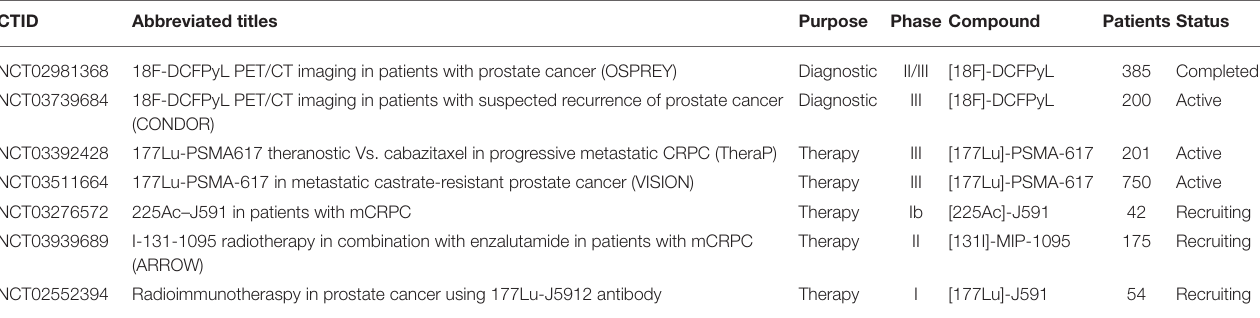
FIGURE 3 | PSMA Targeted radiopharmaceuticals. Examples of diagnostic and therapeutic agents targeting Prostate Specific Membrane Antigen. A common urea-based motif (green) has been widely derivatized for localization at sites of prostate cancer metastases that over-express the membrane-localized PSMA metalloenzyme. Antibody targeting vectors with high affinity for PSMA have also been labeled with positron, beta-particle and alpha-particle emitting radionuclides. TABLE 1 | Selected prostate cancer trials for disease detection and radiotherapy treatment of metastatic